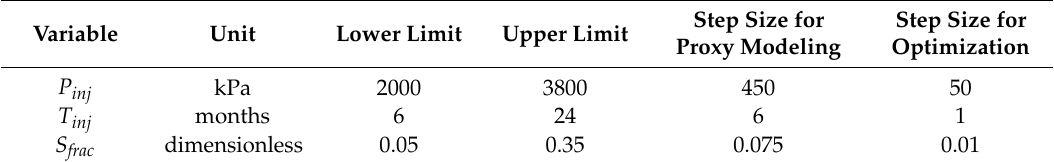
Table 2. Experimental setting of decision variables for proxy modeling and optimization of the ES-SAGD process.